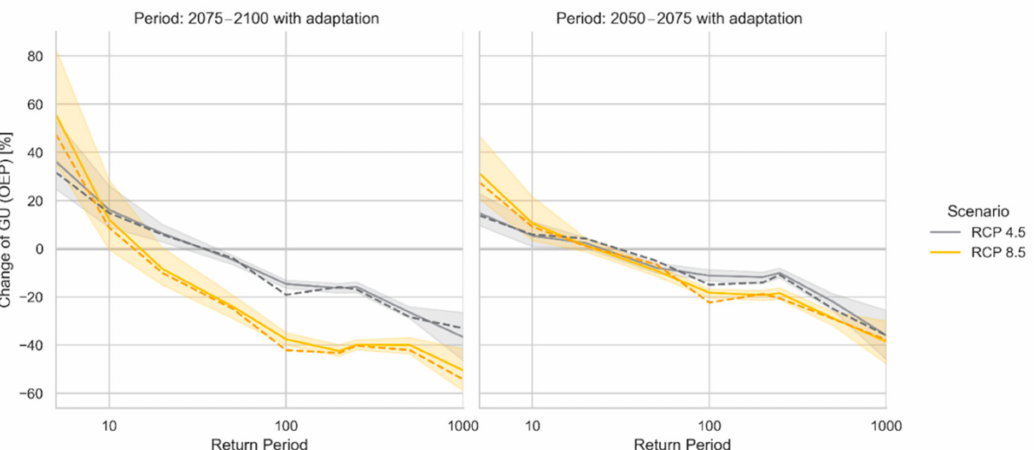
Figure 11. Percentual change of GU (OEP) for the two periods (including an adaptation) and RCP scenarios. The solid line with a filled area represents the mean value with a 95 percent confidence interval based on the portfolios of the seven largest insurers: the dashed line is the aggregated market portfolio (postal code level only)